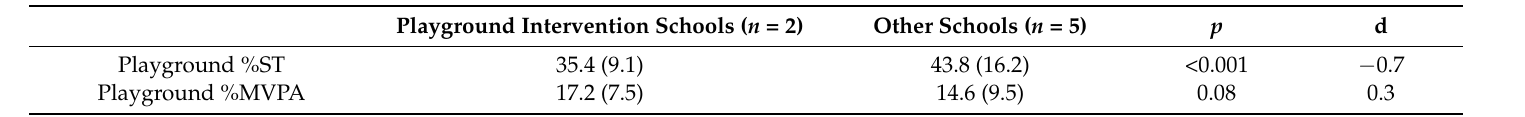
Table 3. Percentage ST and MVPA accrued during the lunch-time break of the schools participating in the playground intervention, and the other remaining schools (mean and standard